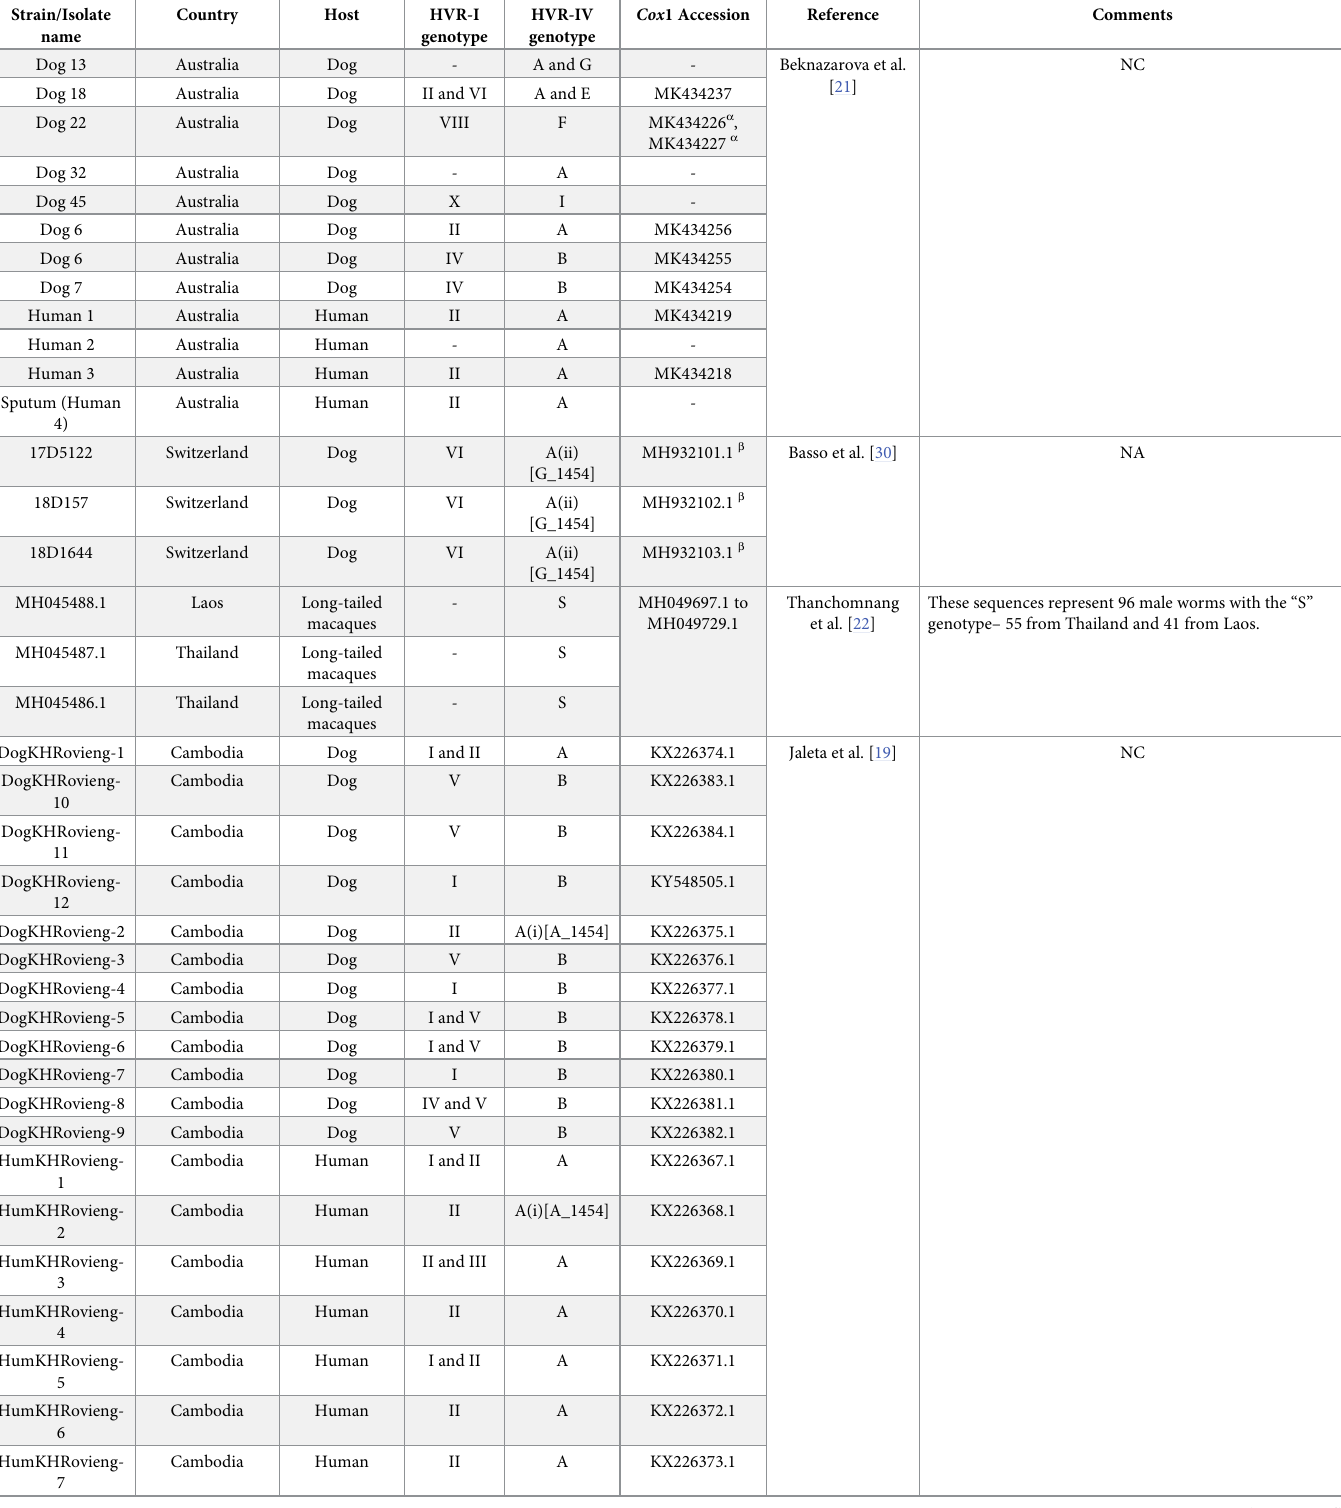
Table 5. Human, primate and dog Strongyloides spp. specimens analyzed in previous studies and their